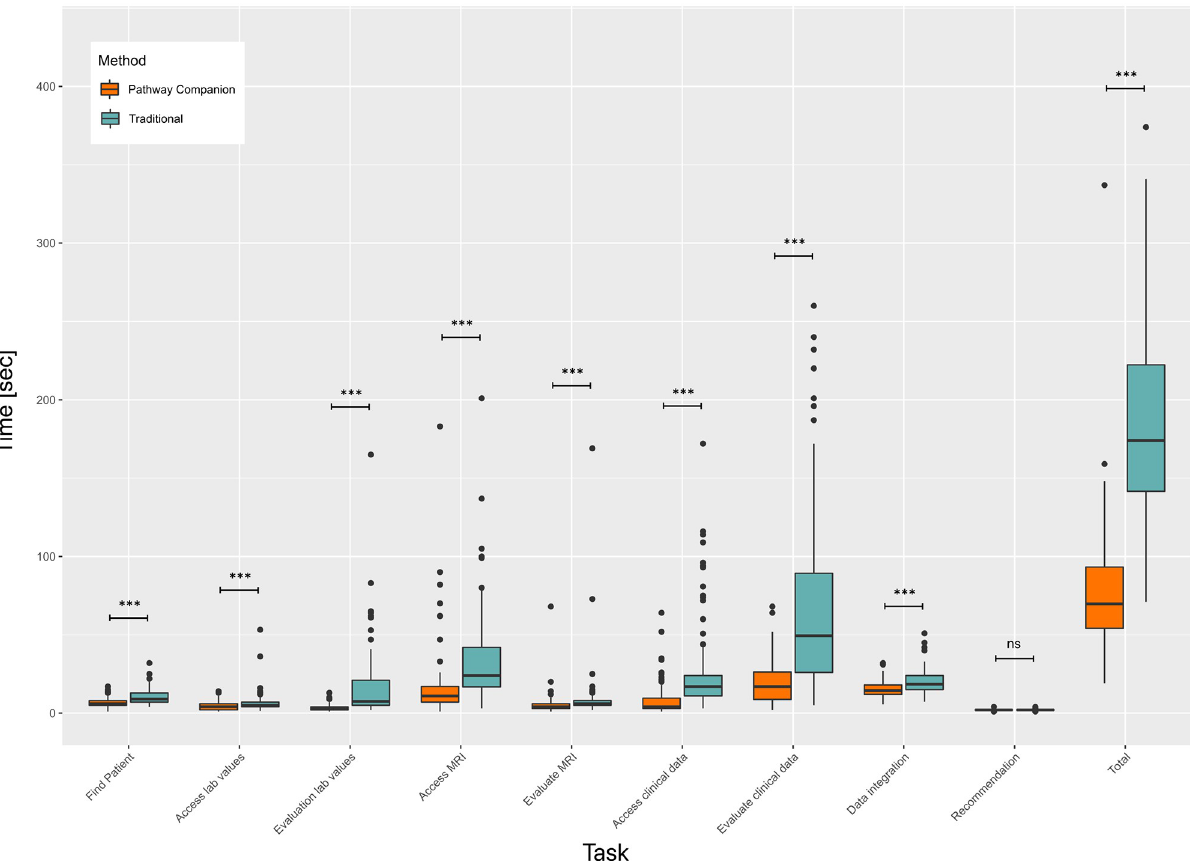
Fig 3. The bar chart shows the time required for a physician to complete the tasks along the prostate cancer screenings pathway. The tasks were completed once with the software and with current method.